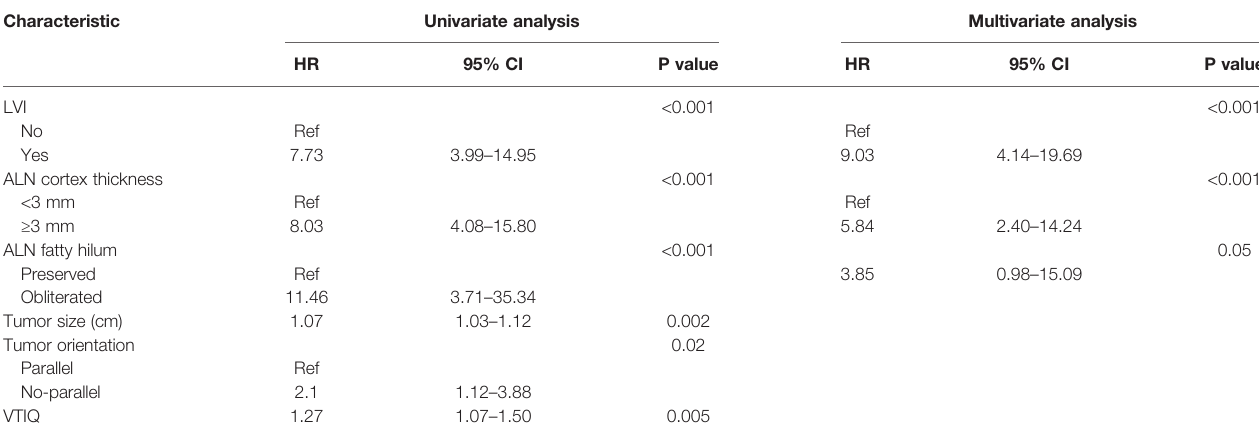
TABLE 2 | Univariate and multivariate analyses of ALNM in the training cohort. Characteristic